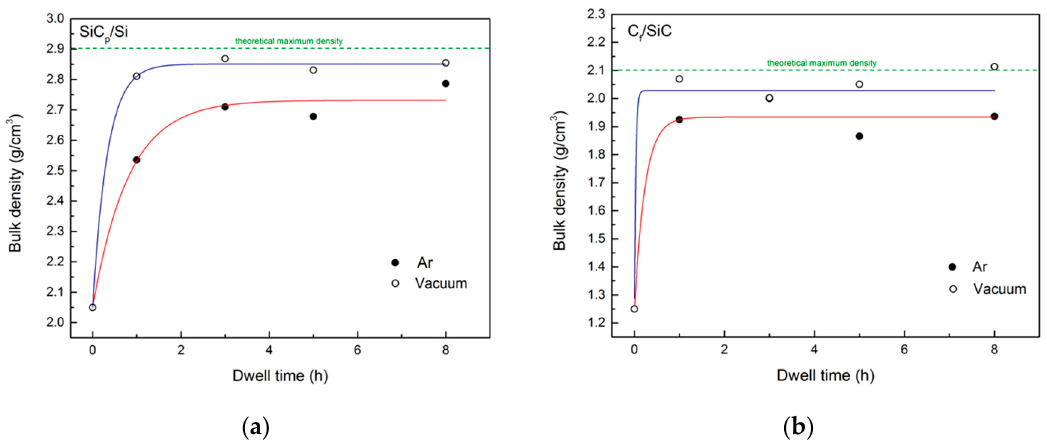
Figure 5. Bulk density as a function of dwell time at 1450 °C under Ar and vacuum atmospheres of SiC p /C ( a ) preforms and C f /C preforms ( b ).